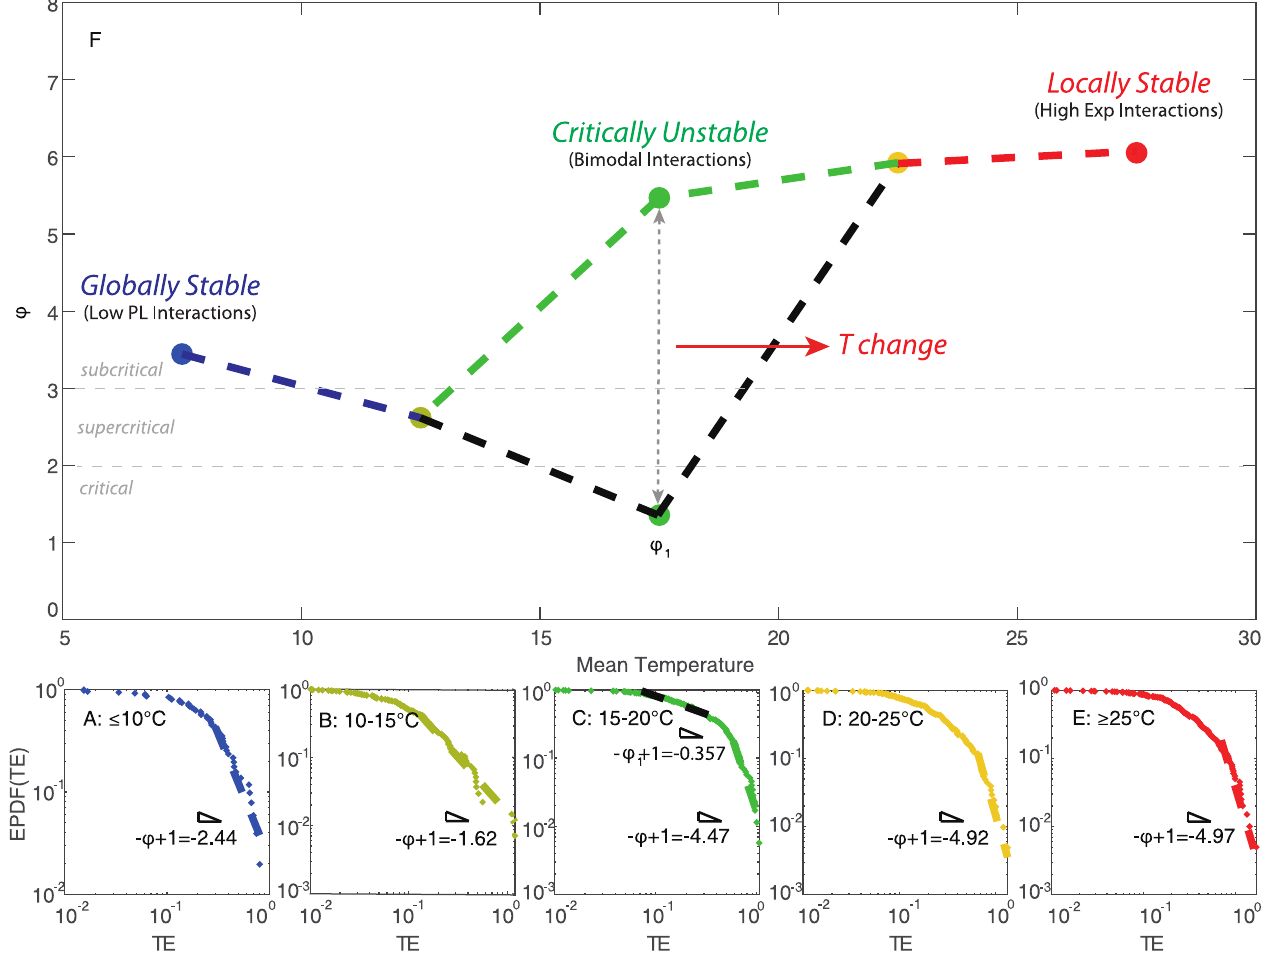
Fig 5. Exceedance probability distribution function of species interactions and phase-space dependent on surface temperature. A , B , C , D and E : Epdfs of OIF-based interactions (after filtering with a threshold of 0.01) between all pairs of species for five TRs: � 10˚C, 10–15˚C, 15–20˚C, 20–25˚C, � 25˚C. The fit is with a power-law function. In plot F , all power-law exponents are connected by dashed lines. Scaling exponents for different TRs are displayed in a phase- space where x-coordinates are middle values of TRs (note that 7.5˚C and 27.5˚C are selected as middle temperature values for TRs lower than 10˚C, and higher than 25˚C, respectively); points are empirically connected by a dashed line from low to high temperature to emphasize phase-transition of interactions. Note that for the 15–20˚C group, epdf of species interactions presents two power-law regimes that are separately fitted by a power-law functions. The double- Pareto distribution reflects the presence of two strange-attractors and a critical unstable transition at 15–20˚C. Critical regimes are defined according to power-law criteria defining finiteness of statistical moments (see